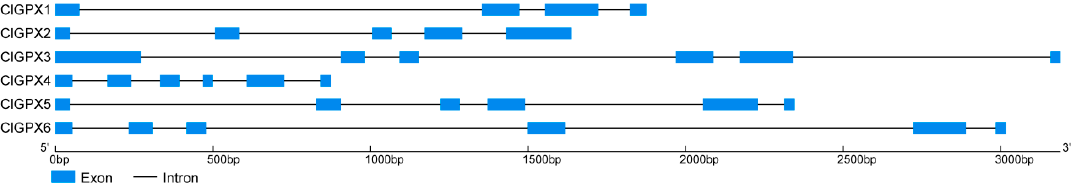
Figure 3. Exon ‐ intron structure analysis of ClGPX genes in watermelon. Gene structure analysis was